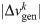
Variation of SNP influence on the levels of transcriptional activation and gene products.Coefficient of variation (the standard deviation to the mean ratio) for different subsets of the set of absolute values |Δvgenk| (blue) and |ΔEgenk| (red) for all genotypes from the study population and all k values. The coefficient was calculated for values of |Δvgenk| or |ΔEgenk| exceeding the percentile values shown on the horizontal axis.